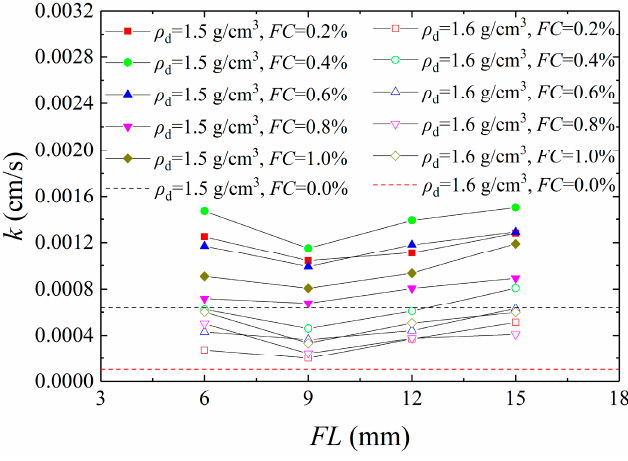
Figure 4. Curves of permeability coefficient versus fiber length.